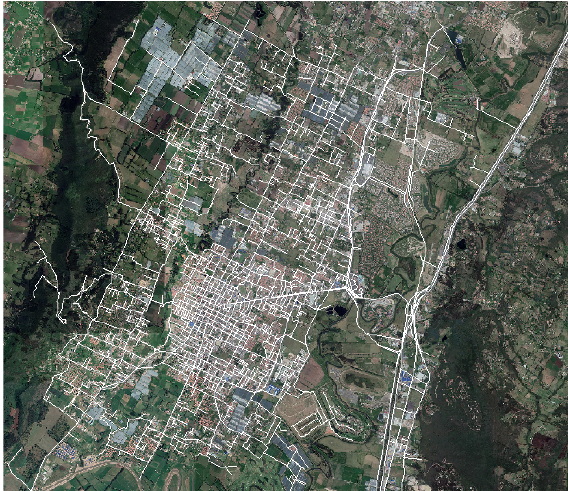
Figure 3. Support for and institutionalization of direct democracy. Source: Geissel